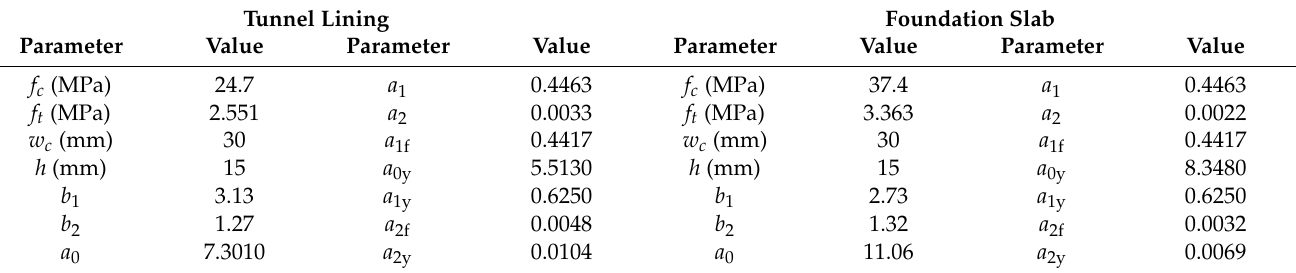
Table 4. Key parameters in the KCC model for the tunnel lining and foundation